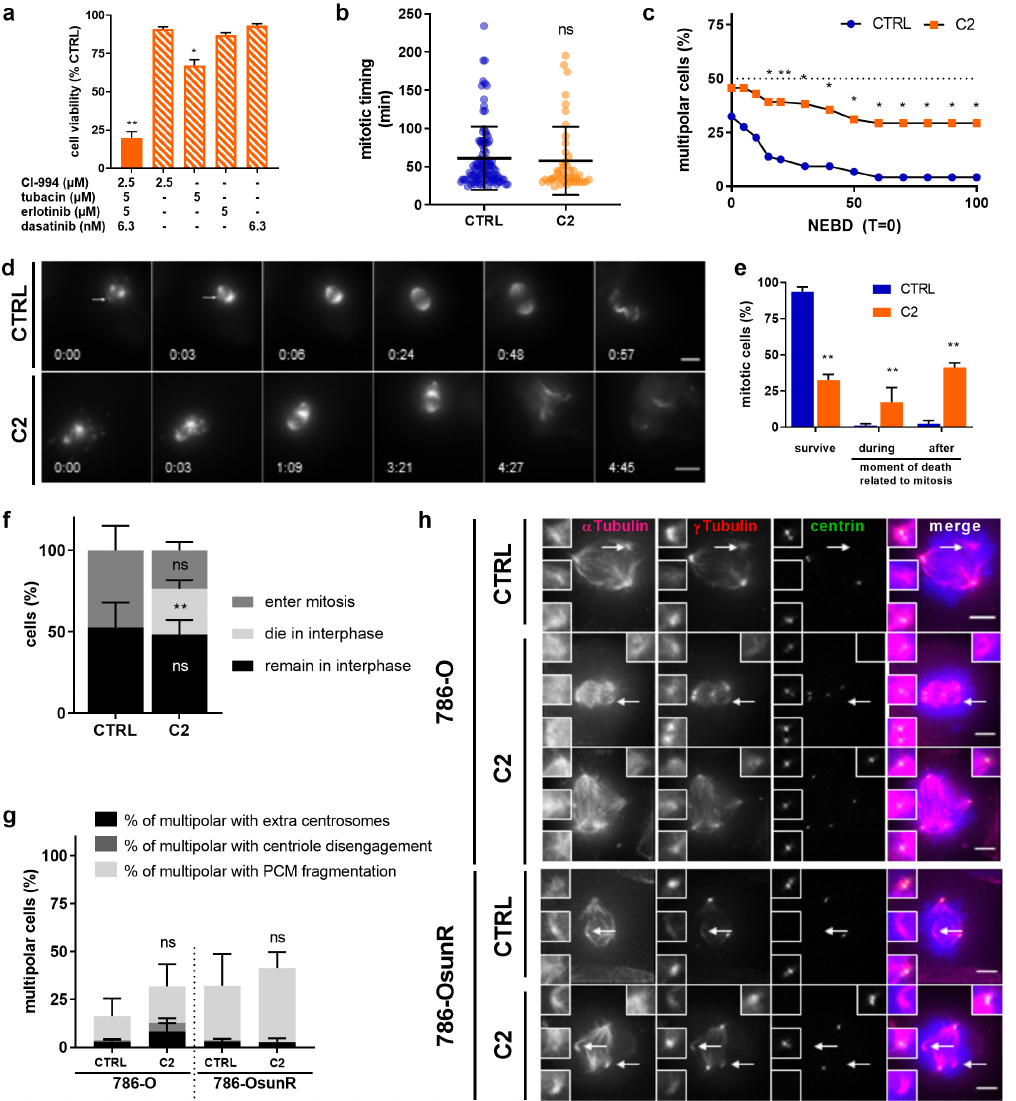
Figure 4. C2 activity also prevents spindle pole clustering in sunitinib-resistant 786-O cells. ( a ) Efficacy of C2 and corresponding single drug treatments in 786-O cells chronically exposed to sunitinib treatment (786-OsunR). ** p < 0.0001 and * p < 0.05 represent significances versus all corresponding single drug treatments from N = 5 independent experiments as determined by a one-way ANOVA with post-hoc Tukey’s multiple comparison test. ( b ) Mitotic timing of 786-OsunR treated with CTRL (0.1% DMSO) or C2 . p = 0.2262 compared to CTRL as determined by a Mann–Whitney Test from N =